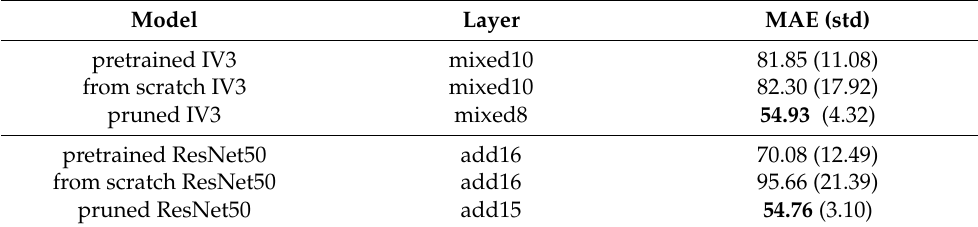
Table 2. Mean Average Error (MAE) of the nuclei area regression (in pixels) and Cohen’s kappa coefficient between the true and predicted magnification categories. Results are averaged across ten repetitions; the standard deviation is reported in